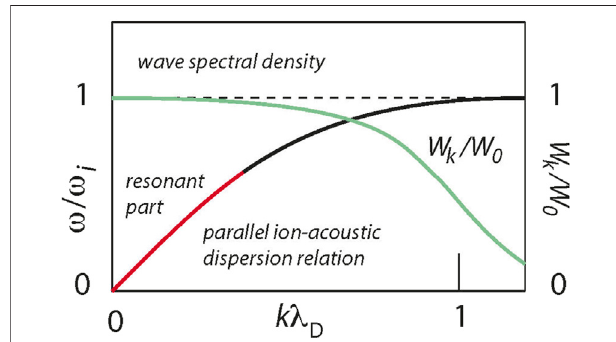
FIGURE 3 | Parallel ion-acoustic wave dispersion relation ω ( k (cid:4) ) / ω i (with ω fi xed k ⊥ and ion-acoustic thermal i being the ion plasma frequency) for background noise spectrum W k / W 0 as a function of k ⊥ λ D . (Note that, on the abscissa, k stands for both, k (cid:4) when referring to the dispersion relation and k ⊥ when meaning the spectral density.) The resonant part of the dispersion relation is shown in red. The spectral density (green) of the ion- acoustic background noise is constant over the resonant range and decays like W k ∝ [ 1 + k 2 ⊥ λ 2 D ( 1 + k 2 (cid:4) / k 2 ⊥ )] − 1 for fi xed k (cid:4) . For resonant electrons, it is constant over several parallel wavelengths and with k ⊥ λ D ∼ λ D / r ci < 1 up to a perpendicular distance of the ion gyroradius r ci